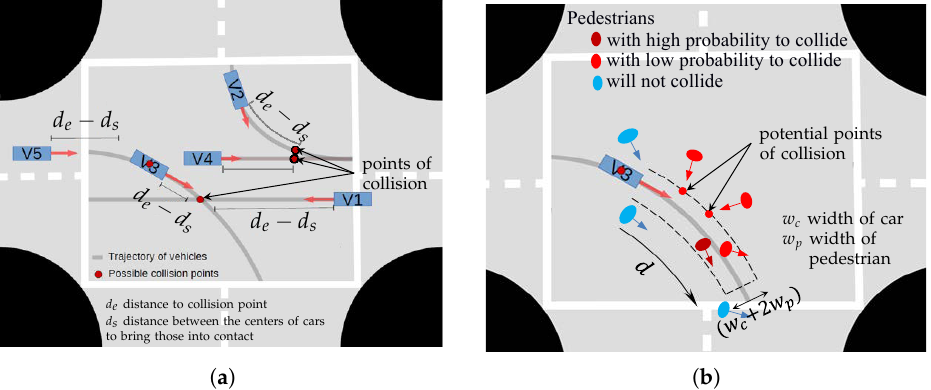
Figure 3. Illustration of potential collision points of cars with neighboring cars and pedestrians: ( a ) Po- tential collision points of cars on different trajectories and safe distance to decelerate; ( b ) Potential collision points of a car with pedestrians.